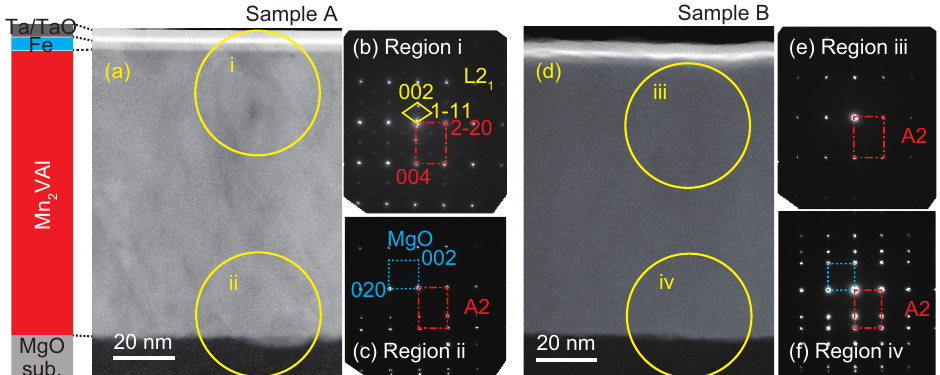
Figure 2. Cross-sectional low-magnification HAADF-STEM images for ( a ) Sample A and ( d ) B. Diffraction patterns around ( b ) the upper interface, region i, and ( c ) bottom interface, region ii of Sample A. Diffraction patterns around ( e ) the upper interface, region iii, and ( f ) the bottom interface region iv of Sample B. The yellow solid lines guide the superlattice diffractions for the L2 1 phase in region i. The broken lines guide diffractions from the MgO substrates in regions ii and iv, and the dashed lines guide diffractions from the A2 phase in regions i to iv.